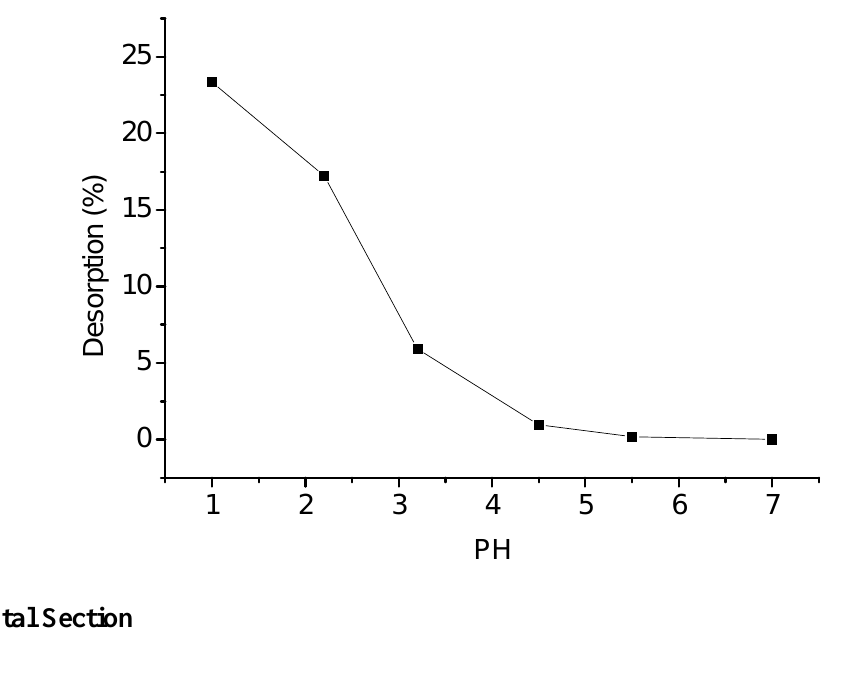
Figure 7. Desorption of DOX from GO by adjusting the pH values of the solution using HNO and NaOH 3